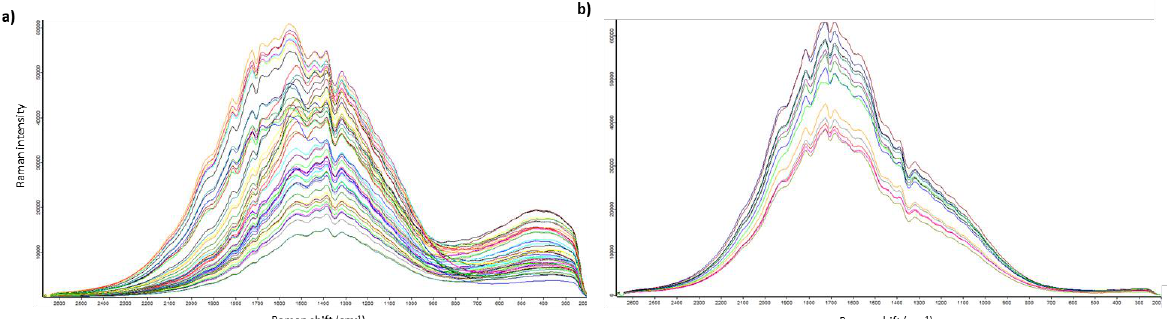
Figure 1. Raw Raman spectra of mixed liquor samples harvested from the SBR on ( a ) cycles A, B and C (samples 1 – 39; 5 sec integration time); and ( b ) cycle D (samples 40 – 52; 200 msec integration time). To extract relevant spectral information, PLS model optimization was carried out by testing different spectra pre-processing strategies in combination with various spectral regions using the OPUS software, as described in Section 2.4. The proper selection of